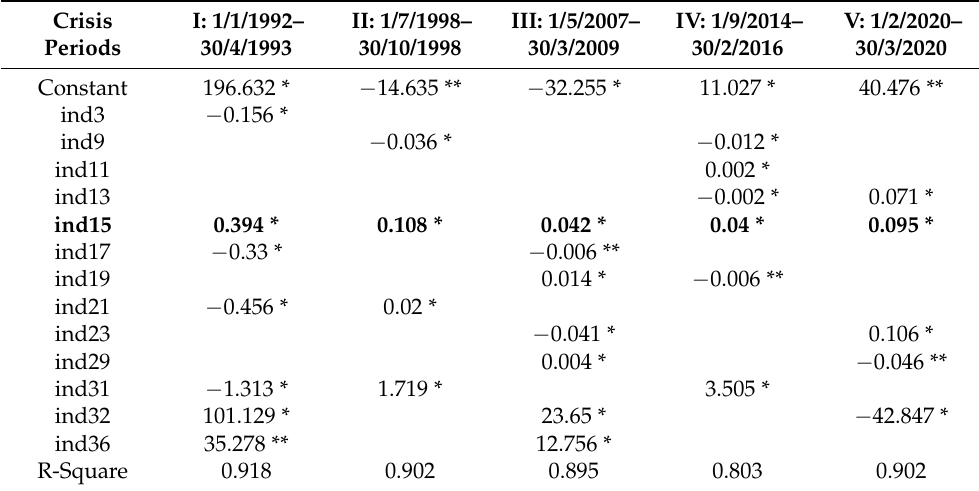
Table 2. Indexes in multiple linear regression models of the Bank of Montreal during the 5 crisis